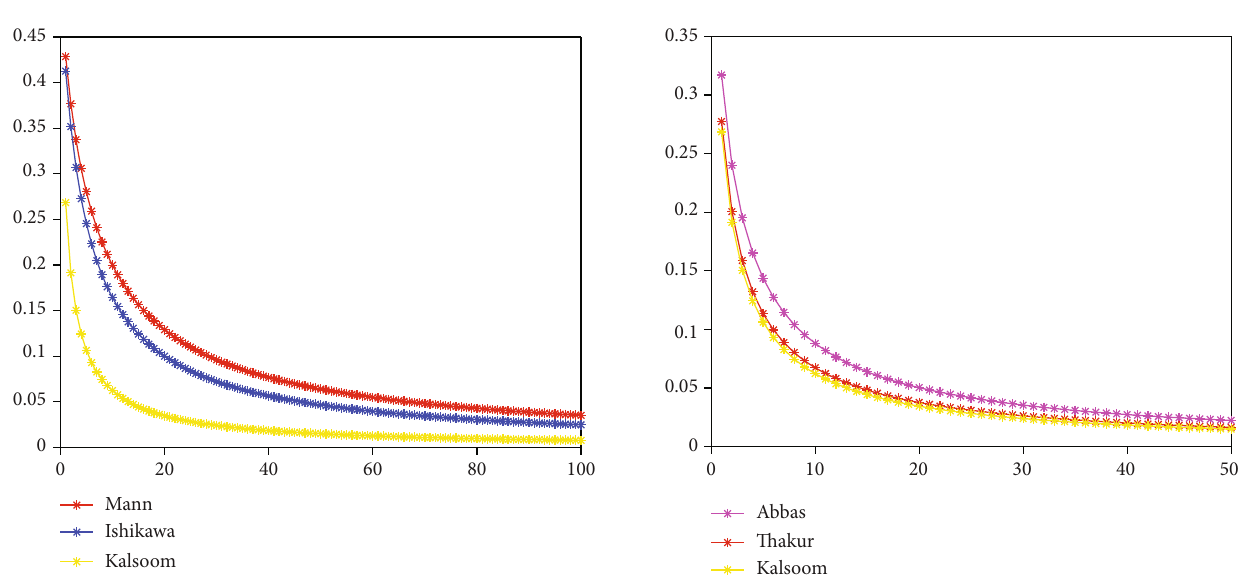
Figure 3: Convergence behavior of Abbas, Thakur, and Kalsoom et al. iterations towards fi xed